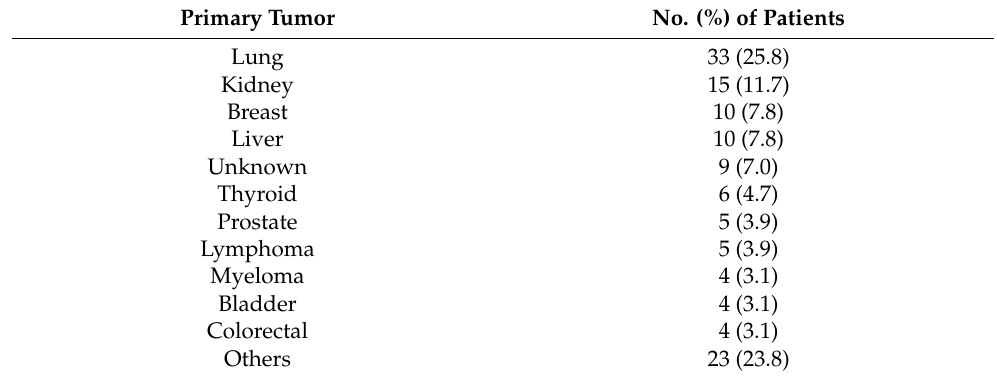
Table 2. Primary cancer types.